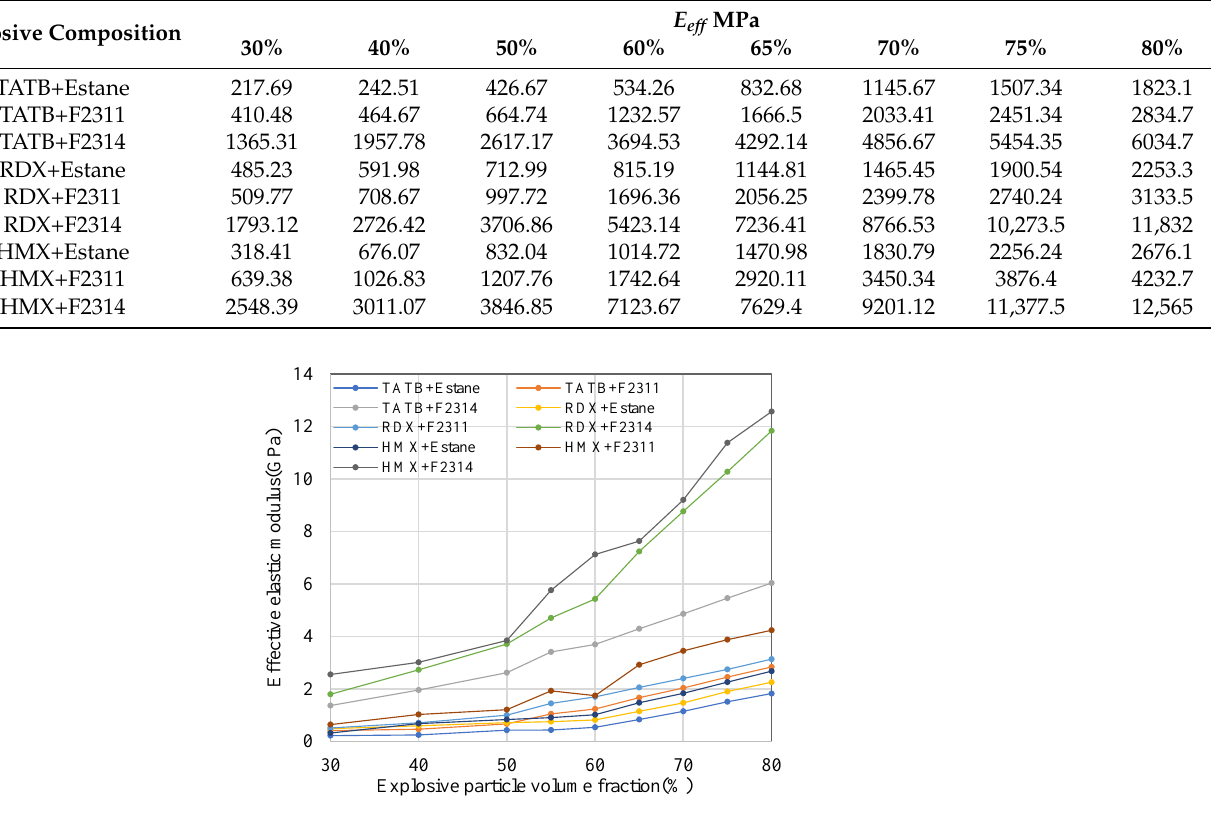
Figure 4. Influential curve of the volume fraction on the effective elastic modulus of PBX.